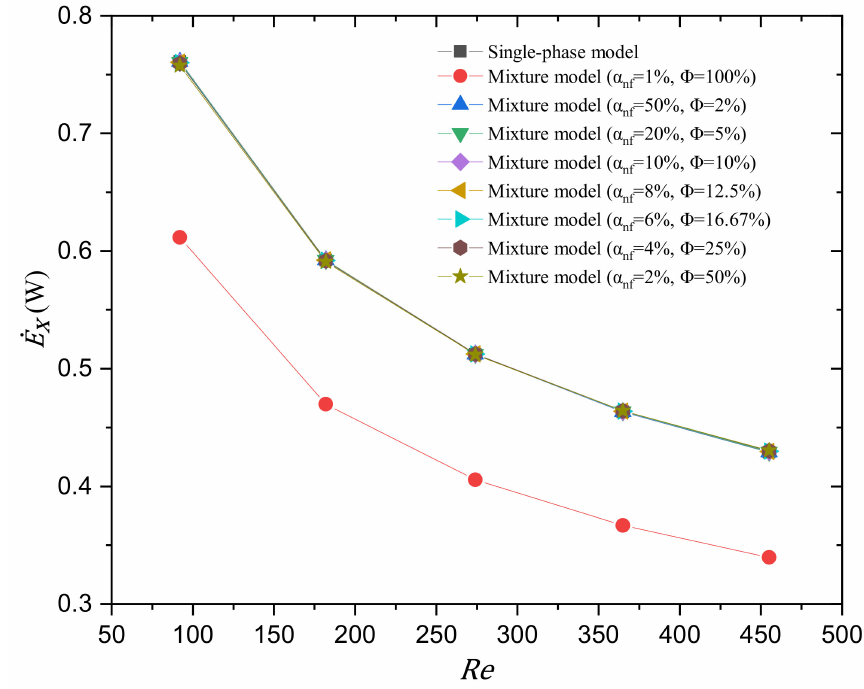
. E x in the minchannel with the Reynolds number,